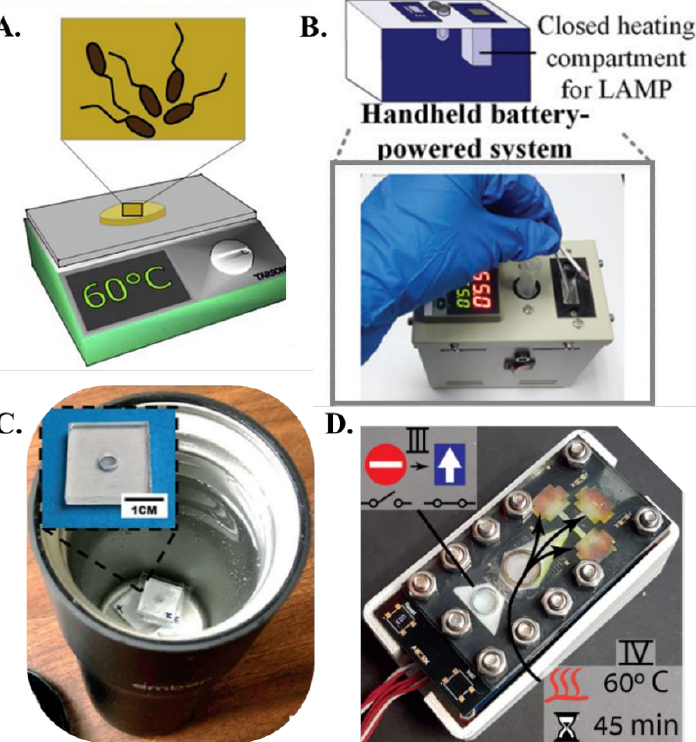
Figure 4. Heating methods ( A ). A hot plate incubator [from [68], copyright 2019 Elsevier]. ( B ). A handheld battery-powered system for paper-based amplification and detection of nucleic acid [from [58], copyright 2016 American Chemical Society]. ( C ). ZIKV detection using VLEAD whereRT-LAMP is carried out in a water bath inside an Ember coffee mug [from [62], copyright 2018 Wiley-VCH GmbH]. ( D ). Paper-based lab-on-a-chip device allowing implementation of multistep assays. The